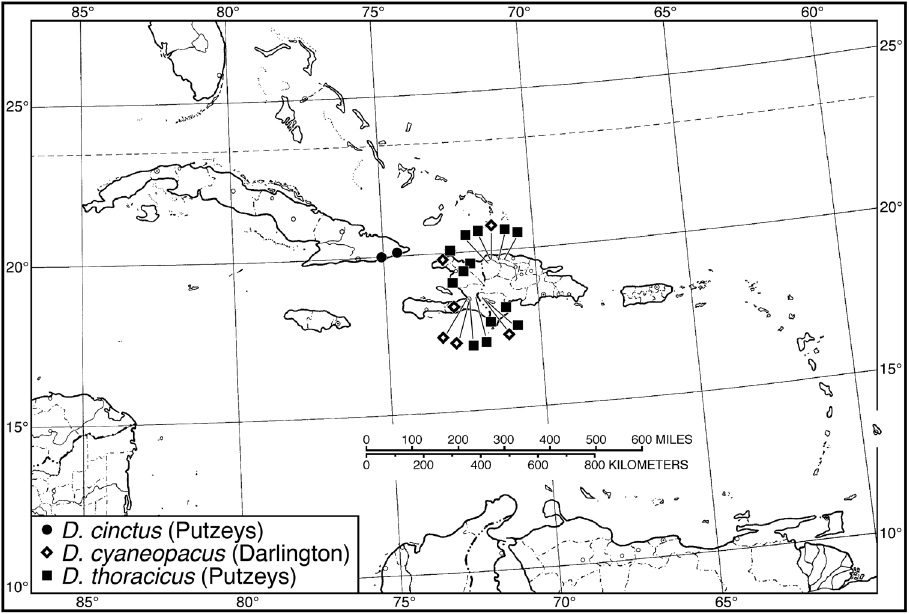
Figure 71. Map of West Indies showing known localities for species of Discoderus LeConte, in